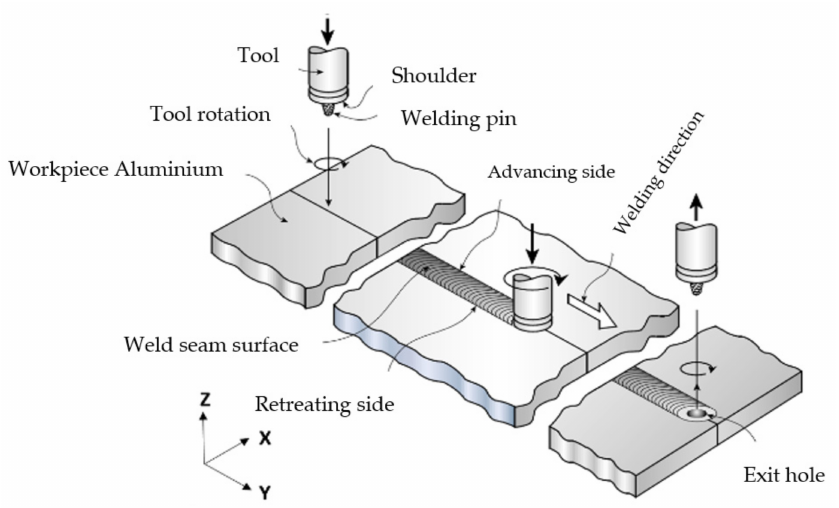
Figure 1. Basic principle of friction stir welding in the example of butt joint following [5].